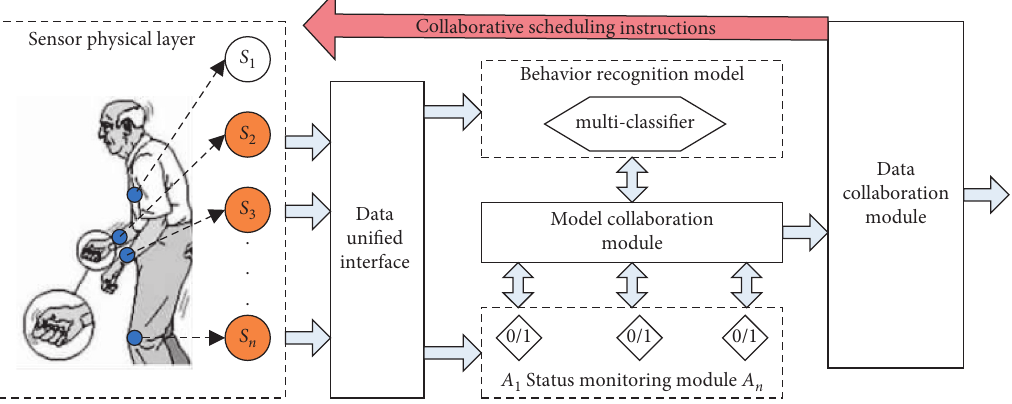
Figure 2: The diagram of the multimodal collaborative sensing